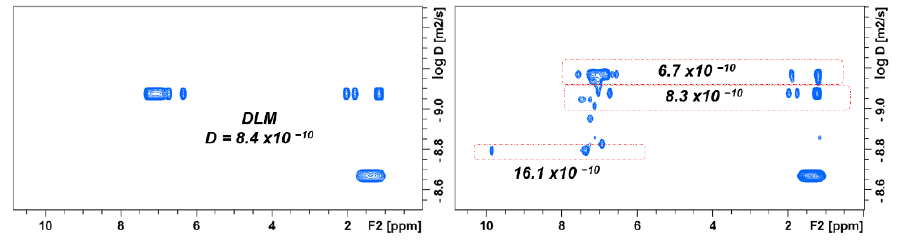
Figure 6. DOSY (600 MHz, C 6 D 12 , 300 K) maps of (left) a -DLM compared to (right) stressed sample.